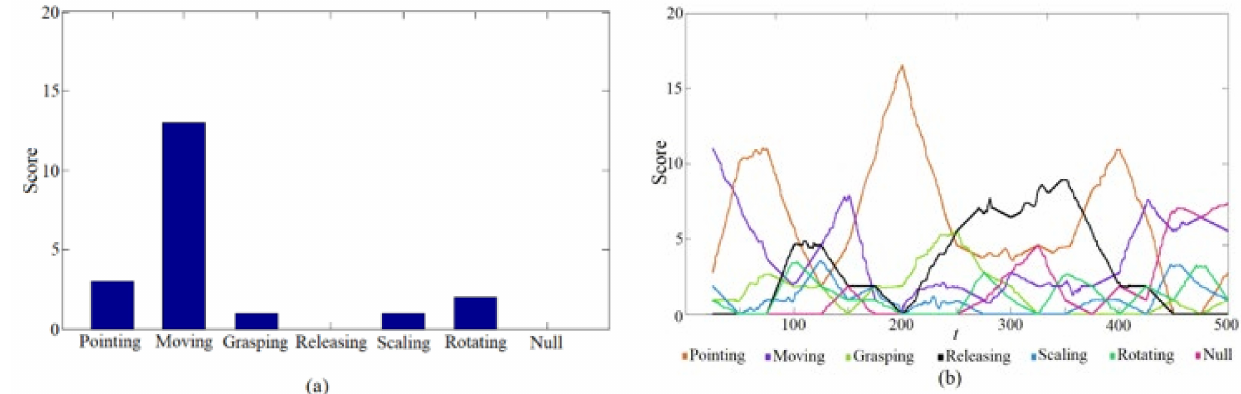
Figure 6. The output of the classifier. ( a ) Scores of each action in an action unit, and ( b ) the score distributions of each action on an input